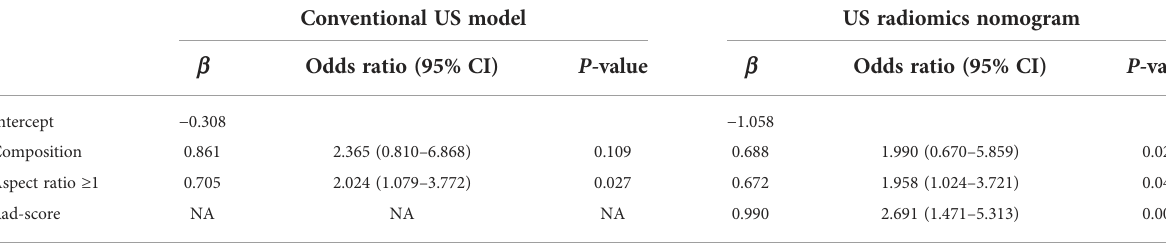
TABLE 3 Independent predictive factors for BRAF mutation of PTMC based on multivariate logistic regression